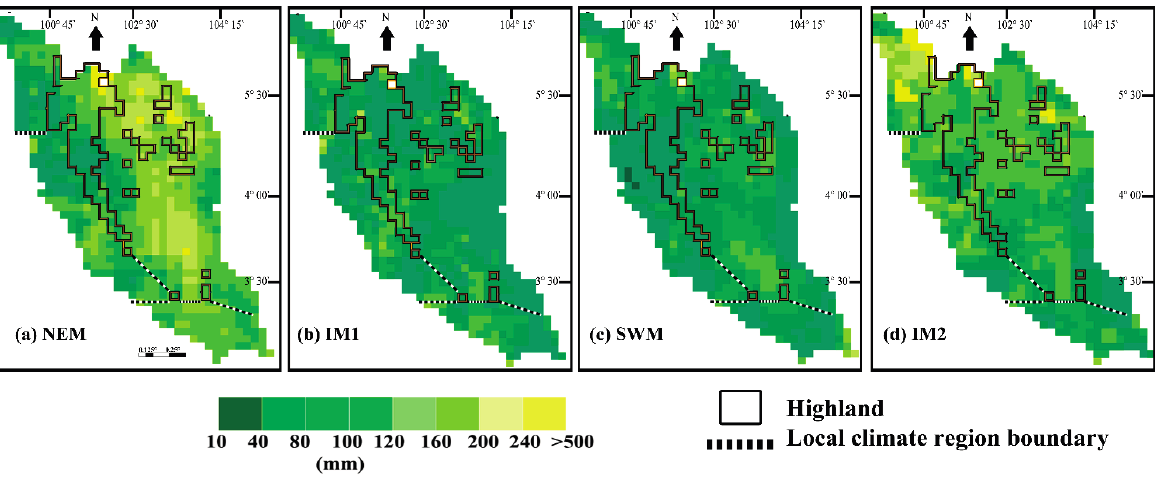
Figure 7. Temporal maps of seasonal RMSE of the TRMM 3B43 against ground rainfall. ( a ) NEM: Northeast monsoon, ( b ) IM1: Inter-monsoon 1, ( c ) SWM: Southwest monsoon, ( d ) IM2: Inter-monsoon